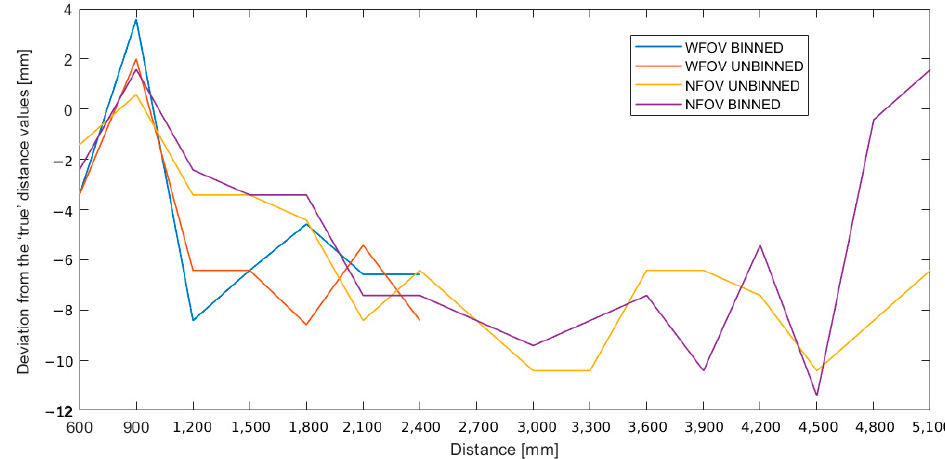
Figure 12. Evolution of the deviations, in mm, from the “true” distances.